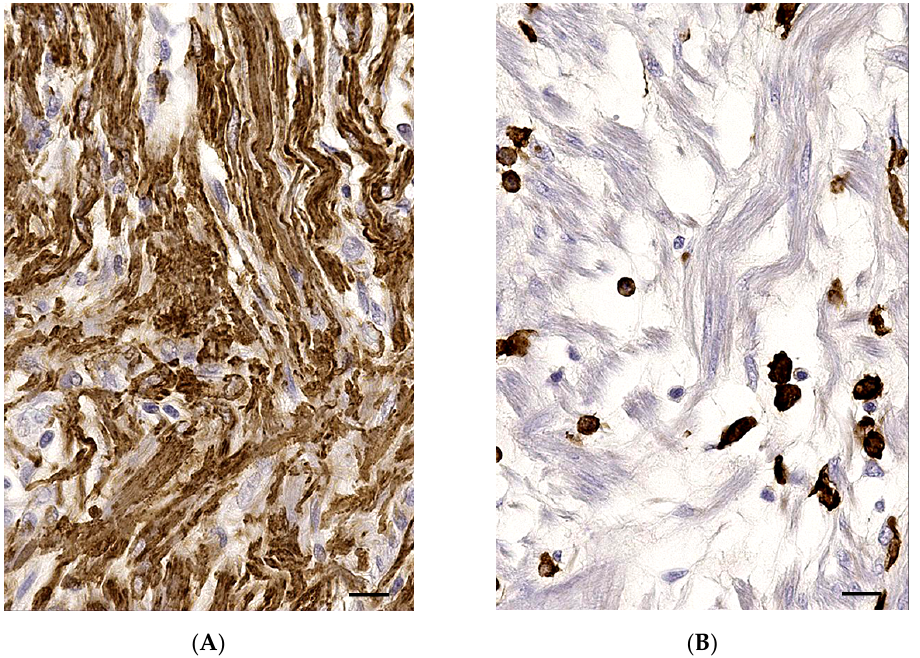
Figure 3. Myofibroblastic inflammatory tumor, spleen, cat. ( A ) Moderate cytoplasmic immunolabeling of the atypical spindle cells. Immunohistochemistry (IHC) for α-SMA. Bar = 50 μm, magnification 20×. ( B ) Marked cytoplasmic immunolabeling of the disseminated round cell population (histiocytes). IHC of Iba1. Bar = 50 μm, magnification 20×.